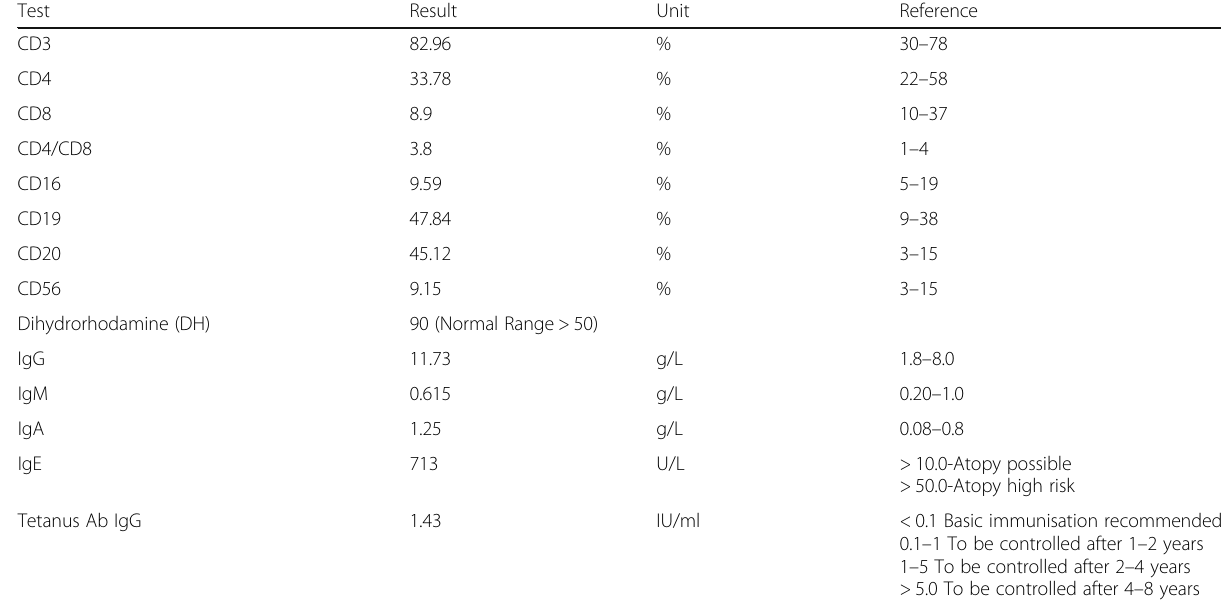
Table 2 Results of flow cytometry and immunoglobulin study in the proband at the age of 4 months